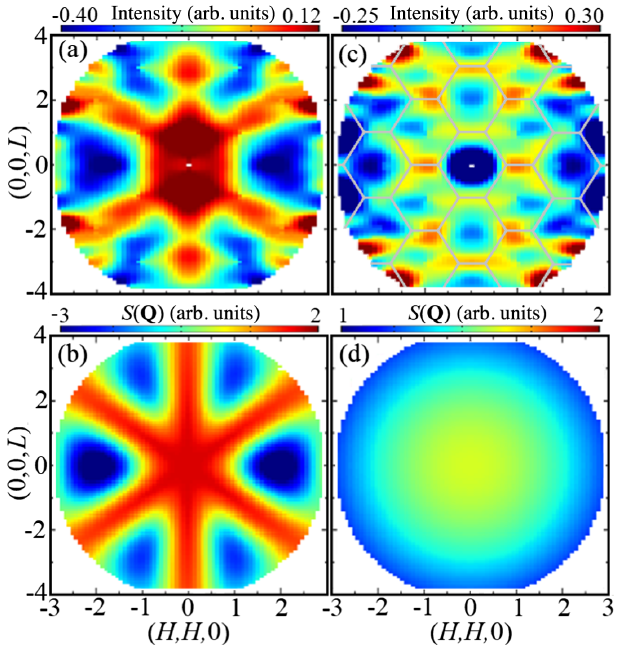
FIG. 8. (a) The symmetrized T ¼ 45 mK − T ¼ 10 K temper- ature-difference neutron signal measured in the SF channel of our polarized neutron diffraction experiment. (b) The NLC-calculated equal-time structure factor for SF scattering in the ½ HHL (cid:2) plane at T ¼ 0 . 5 K with a T ¼ 10 K temperature subtraction. (c) The symmetrized T ¼ 45 mK − T ¼ 10 K temperature-difference neutron signal measured in the NSF channel of our polarized neutron diffraction experiment. The gray lines show the Brillouin zone boundaries. (d) The NLC-calculated equal-time structure factor for NSF scattering in the ½ HHL (cid:2) plane at T ¼ 0 . 5 K with a T ¼ 10 K temperature subtraction. Both (b) and (d) are calcu- lated using the experimental estimates for the A near-neighbor exchange parameters yielded in this work (see main text).